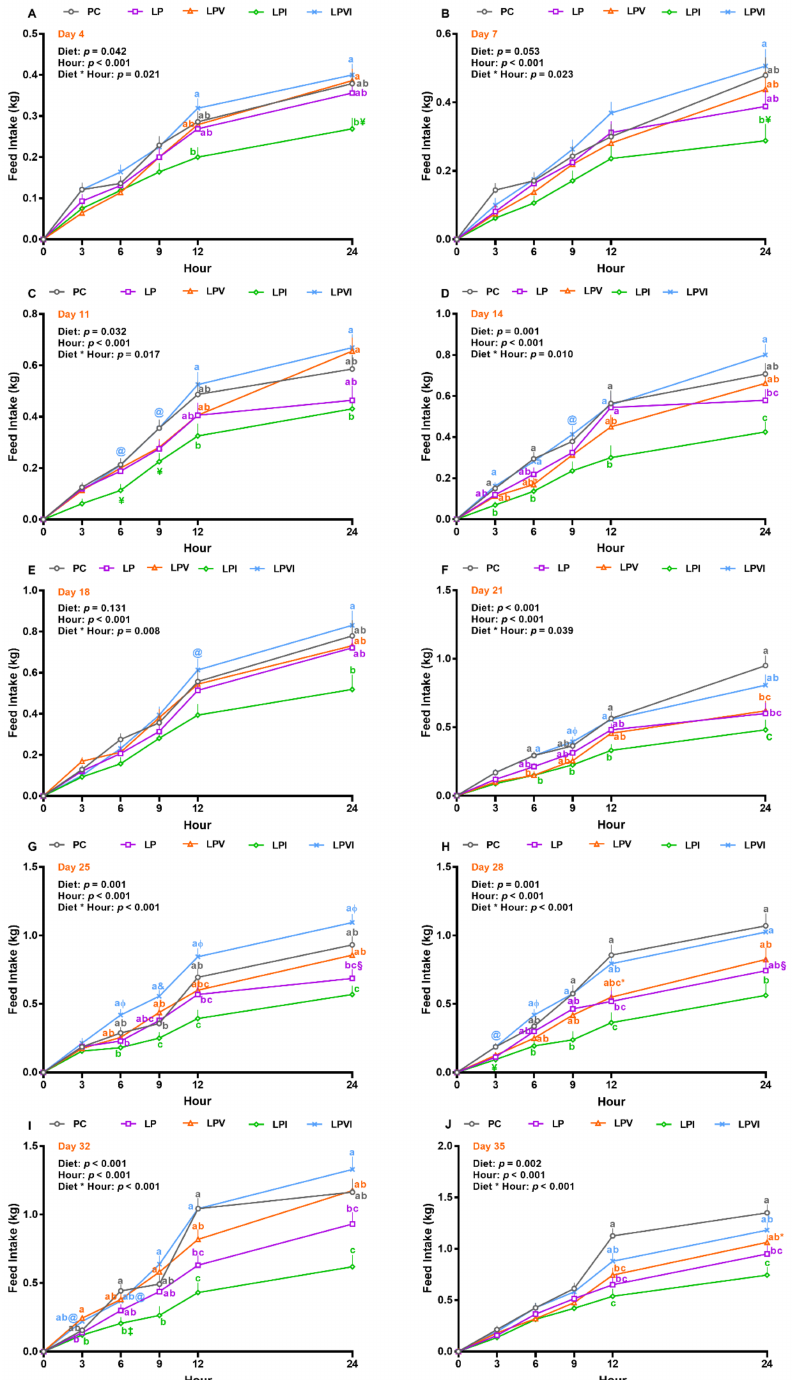
Figure 2. Feed intake at ( A ) Day 4, ( B ) Day 7, ( C ) Day 11 ( D ) Day 14, ( E ) Day 18, ( F ) Day 21, ( G ) Day 25, ( H ) Day 28, ( I ) Day 32, ( J ) Day 35 in nursery pigs fed with very-low-protein diets supplemented with Ile, Val, or combination of both. PC (positive control): standard-protein diet; LP (negative control): low-protein diet containing limiting amino acids (i.e., Lys, Met, Thr and Trp) at NRC (2012) levels; LPV: LP containing Val at NRC level; LPI: LP containing Ile at NRC level; LPVI: LP containing Val and Ile at NRC levels. The values are means ± standard error of the mean. n = 8. a,b,c Among groups, the means with different superscript letter(s) are different ( p ≤ 0.05). § p ≤ 0.1 LP vs. PC, * p ≤ 0.1 LPV vs. PC, ¥ p ≤ 0.1 LPI vs. PC, & p ≤ 0.1 LPVI vs. LP, ‡ p ≤ 0.1 LPI vs. LPV, φ p ≤ 0.1 LPVI vs.